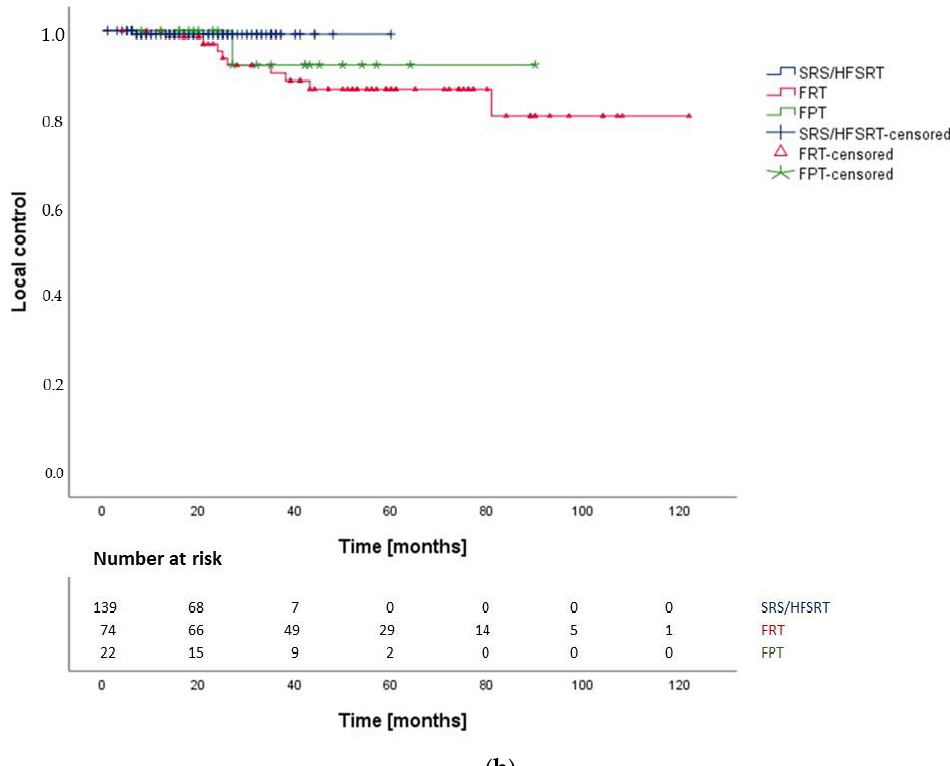
Figure 1. ( a ) LC after RT in 235 patients; ( b ) LC after SRS/HFSRT ( n = 139) vs. FRT ( n = 74) vs. FPT ( n = 22) ( p = 0.19); SRS-HFSRT/FRT (HR: 0.2, 95%-CI: 0.0 – 1.5), SRS-HFSRT/FPT (HR: 0.3, 95%-CI: 0.0 – 4.7) and FRT/FPT (HR: 1.8, 95%-CI: 0.2 – 14.3).